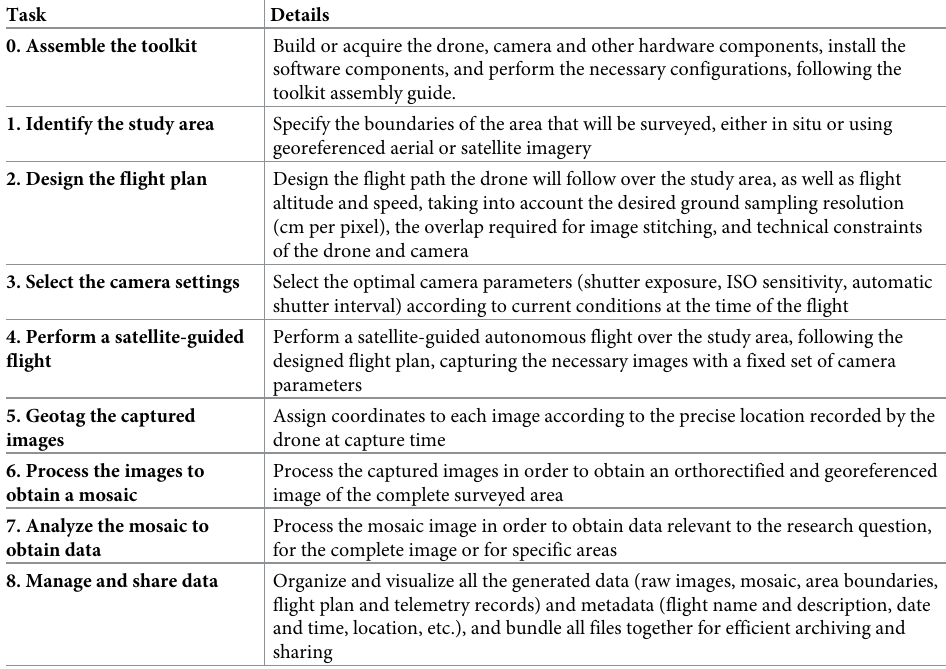
Table 1. Tasks that can be performed using the Open Science Drone Toolkit in order to obtain data from aerial images.